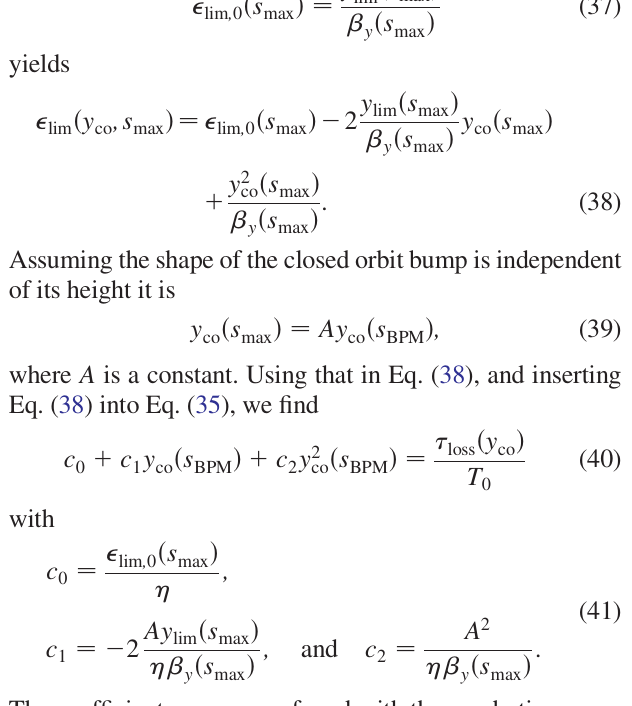
FIG. 3. Loss times determined from the measured current shown in Fig. 2 and the corresponding regression parabola as a function of the closed orbit bump y co 0 : 005 =T 100 MeV = u 0 , and E ¼